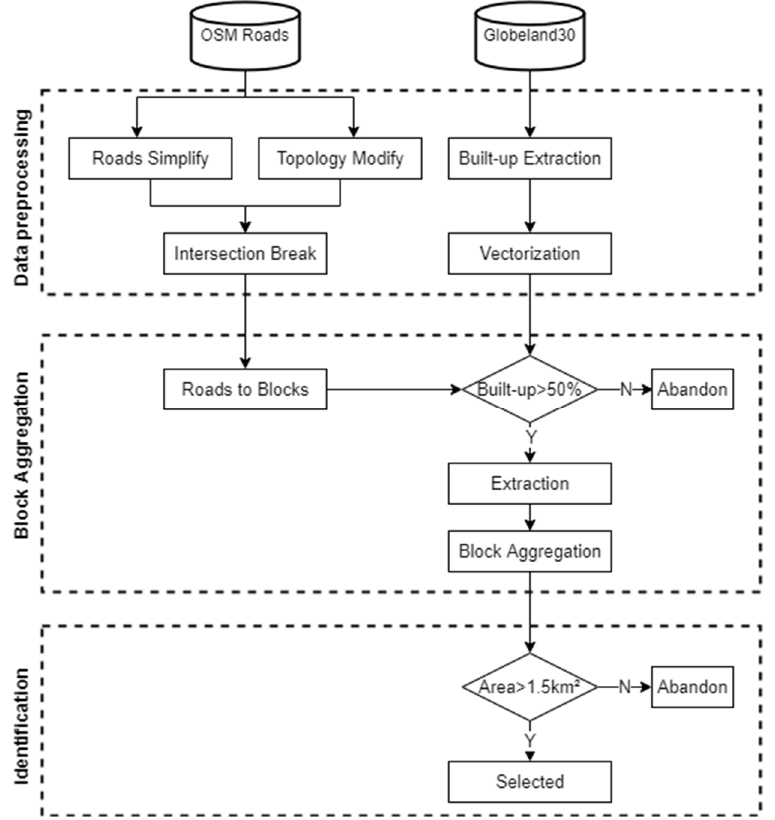
Figure 3. Flow chart of PUB extraction.